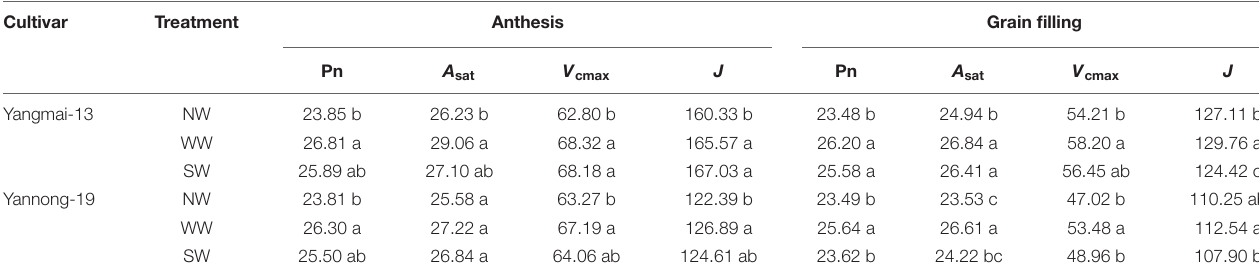
TABLE 1 | Net photosynthetic rate (Pn, µ mol CO 2 m − 2 s − 1 ), maximum photosynthetic rate ( A sat , µ mol m − 2 s − 1 ), maximum carboxylation rate ( V cmax , mol m − 2 s − 1 ), and maximum rate of photosynthetic electron transport ( J , mol mol − 1 ) of flag leaves at anthesis and grain-filling stage as affected by winter (WW) and spring (SW) night-warming during